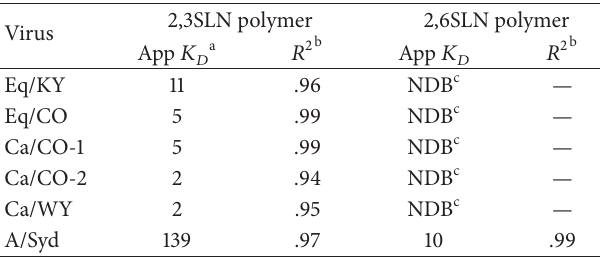
Table 4: Approximate binding affinity of equine and canine influ- enza viruses.